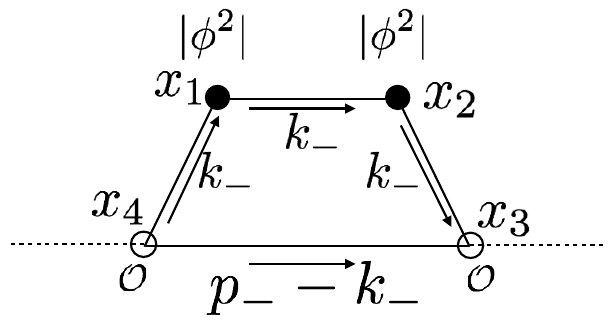
Figure 11 . Four-point diagram in mixed position/momentum space, contributing to H e(cid:11) for external states at second order in the Dyson series in the free O ( N ) model with a mass-squared O (cid:30) 2